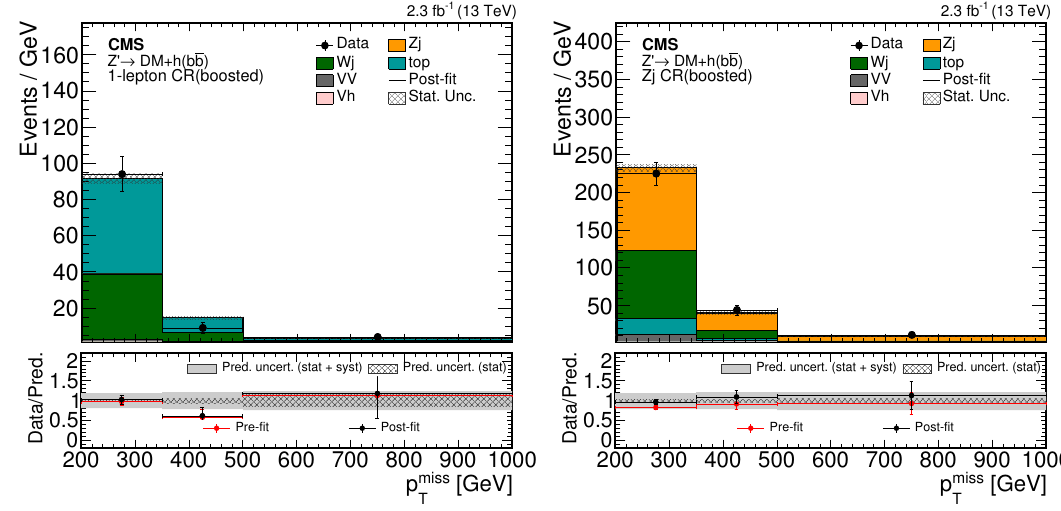
Figure 5 . Post-(cid:12)t distribution of p miss expected from SM backgrounds and observed in data for the T single-lepton CR and Z( ! (cid:23)(cid:23) )+jets CRs for the boosted regime. The bottom panels show the data- to-simulation ratios for pre-(cid:12)t (red markers) and post-(cid:12)t (black markers) background predictions with a hatched band corresponding to the uncertainty due to the (cid:12)nite size of simulated samples and a gray band that represents the systematic uncertainty in the post-(cid:12)t background prediction (see section 6). The last bin includes all events with p miss > 500 GeV. T